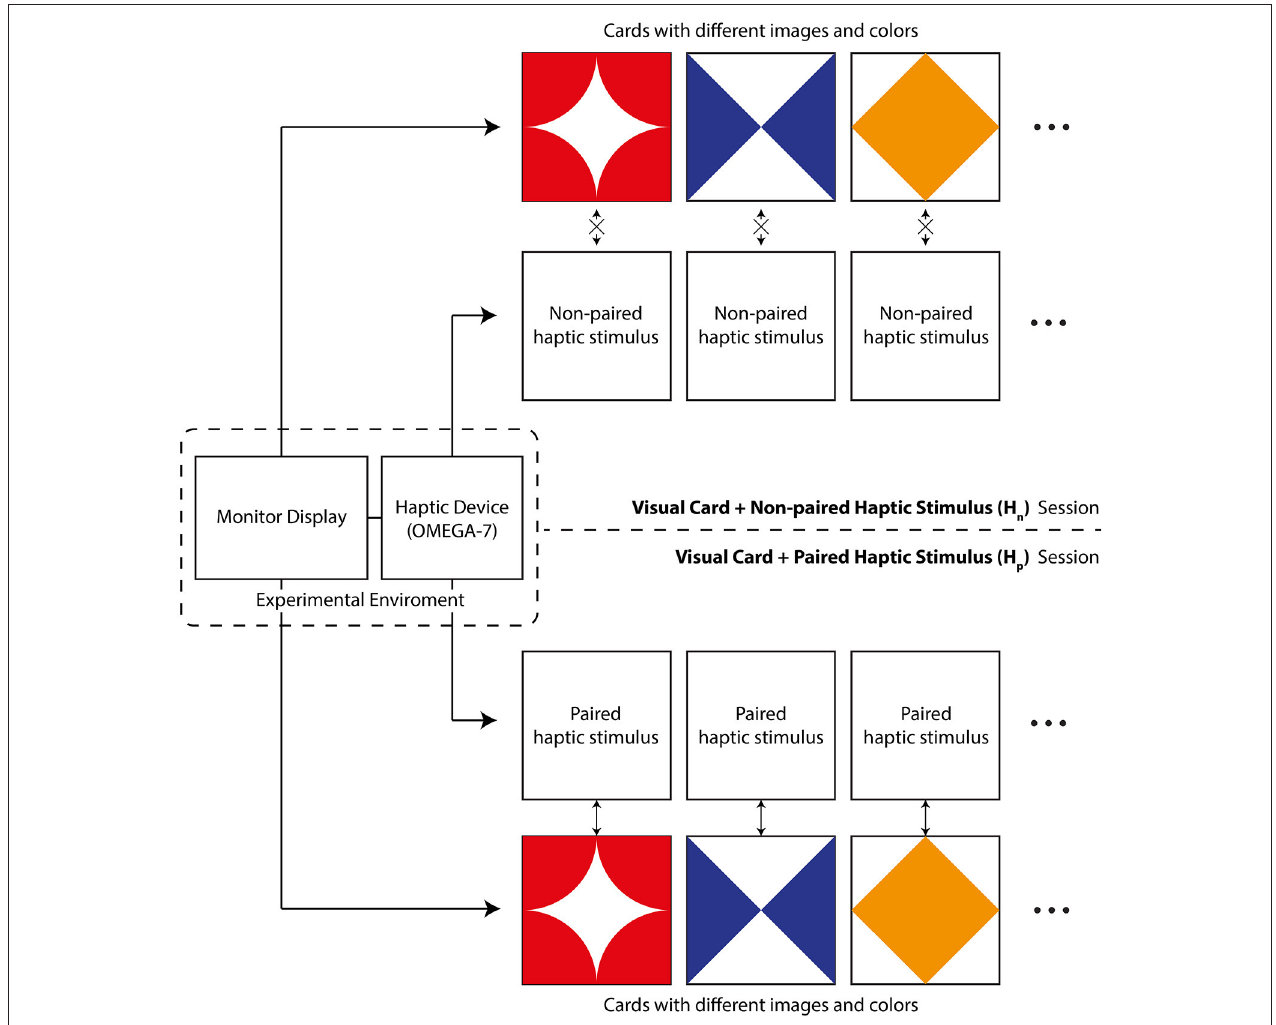
FIGURE 3 | Overall schematic of the visuo-tactile two-back